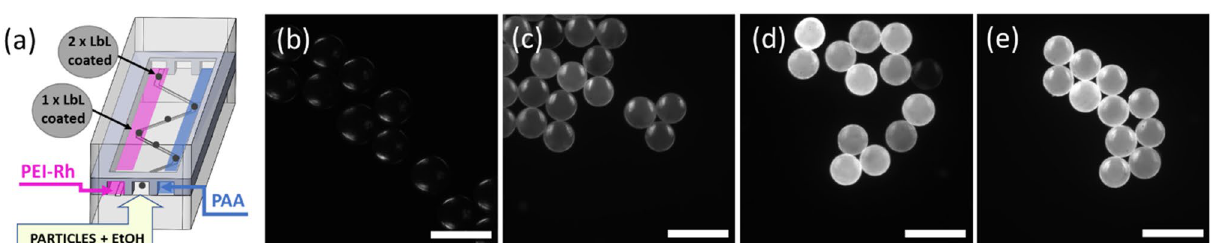
Figure 10. Schematic representation of a PMMA-NH2 particle deposited with poly (acrylic acid) (PAA) and poly (ethylenimine) labeled with Rhodamine (PEI-Rh) bilayers by the layer-by-layer (LbL) technique. Steps 1–4 show the deposition of one bilayer of PAA/PEI-Rh (LbL-1-PMMA-NH2) on a PMMA-NH2 particle. Steps 5–8 show the deposition of second bilayer of PAA/PEI-Rh (LbL-2-PMMA-NH2) on a particle.